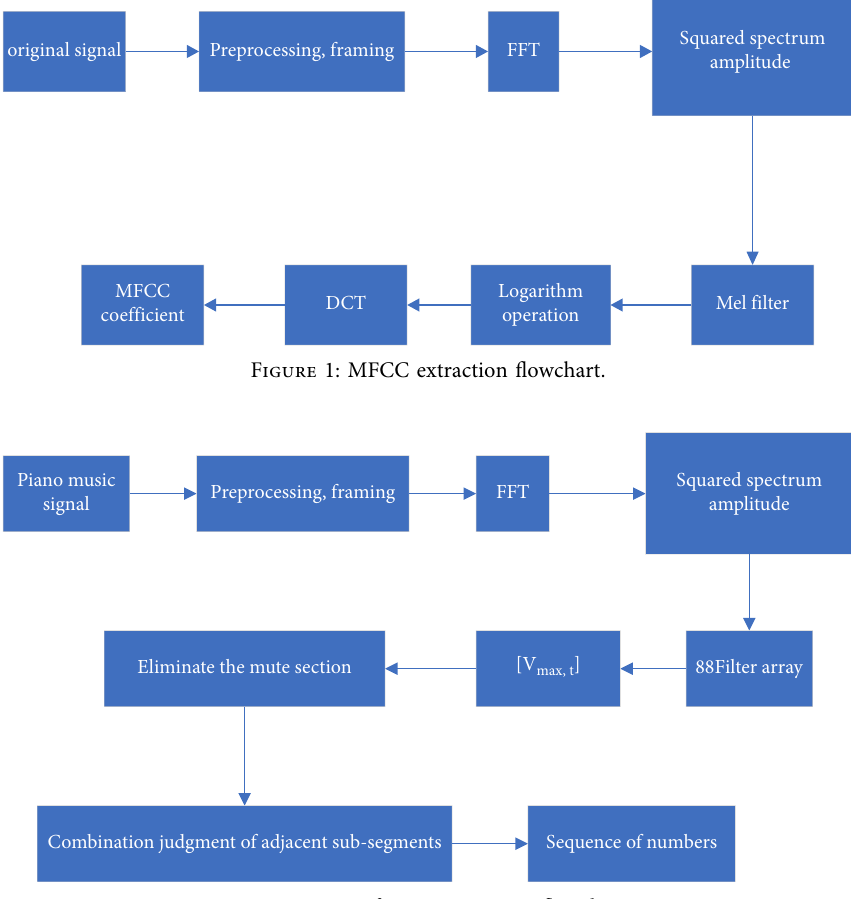
Figure 2: Note feature extraction flowchart.